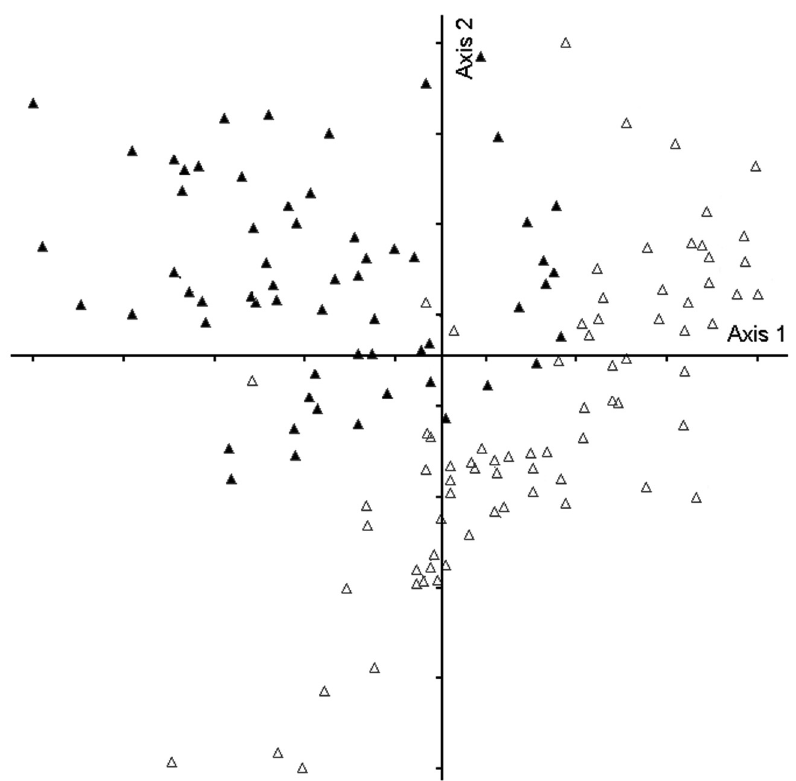
Figure 2 - Biplot graph showing the separation between irrigated and drainage sites in